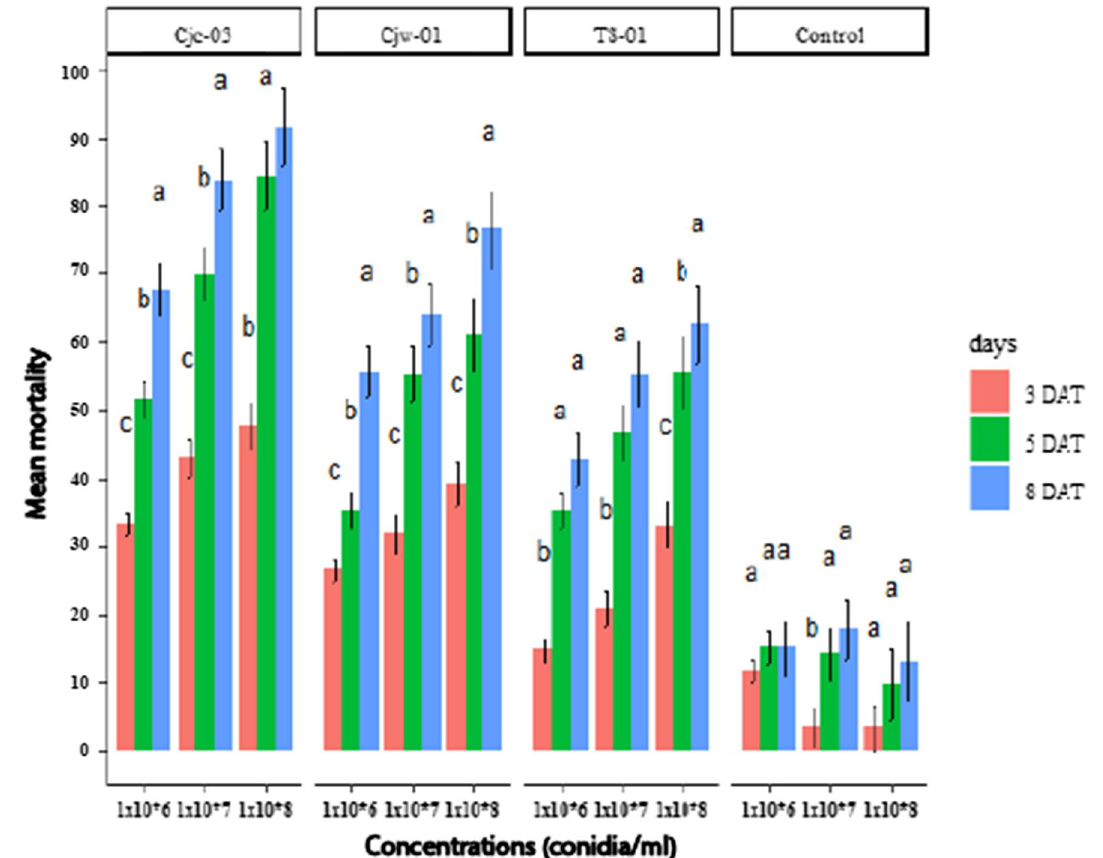
Fig. 4 Mortality (%) of Bemisia tabaci at different time intervals (3, 5, and 8 DAT) with 3 fungal isolates Isaria javanica , (Cjc-03, Cjw-01), and Purpureocillium lilacinum (TS-01) at three concentrations of each fungal isolates and control treatment. The column shows the % mortality. Treatment columns with different alphabets are significantly different from other treatments (LSD test at p